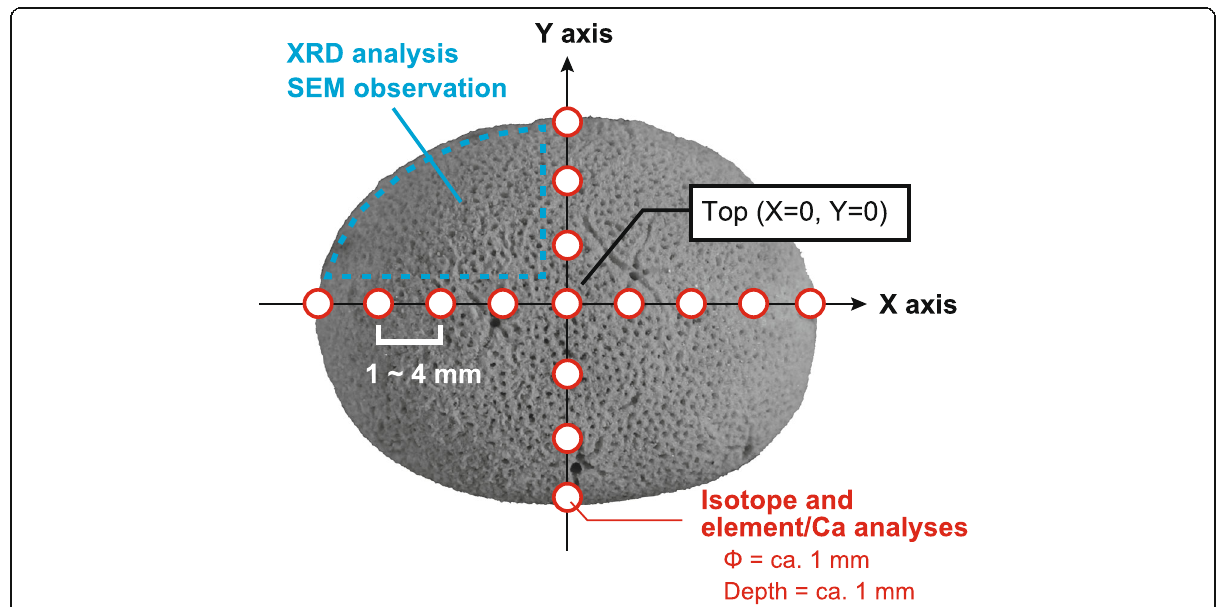
Fig. 4 Example showing the sub-sampling method conducted on a sclerosponge specimen. Subsamples for geochemical analyses (red) and for XRD analysis and SEM observation (blue) were